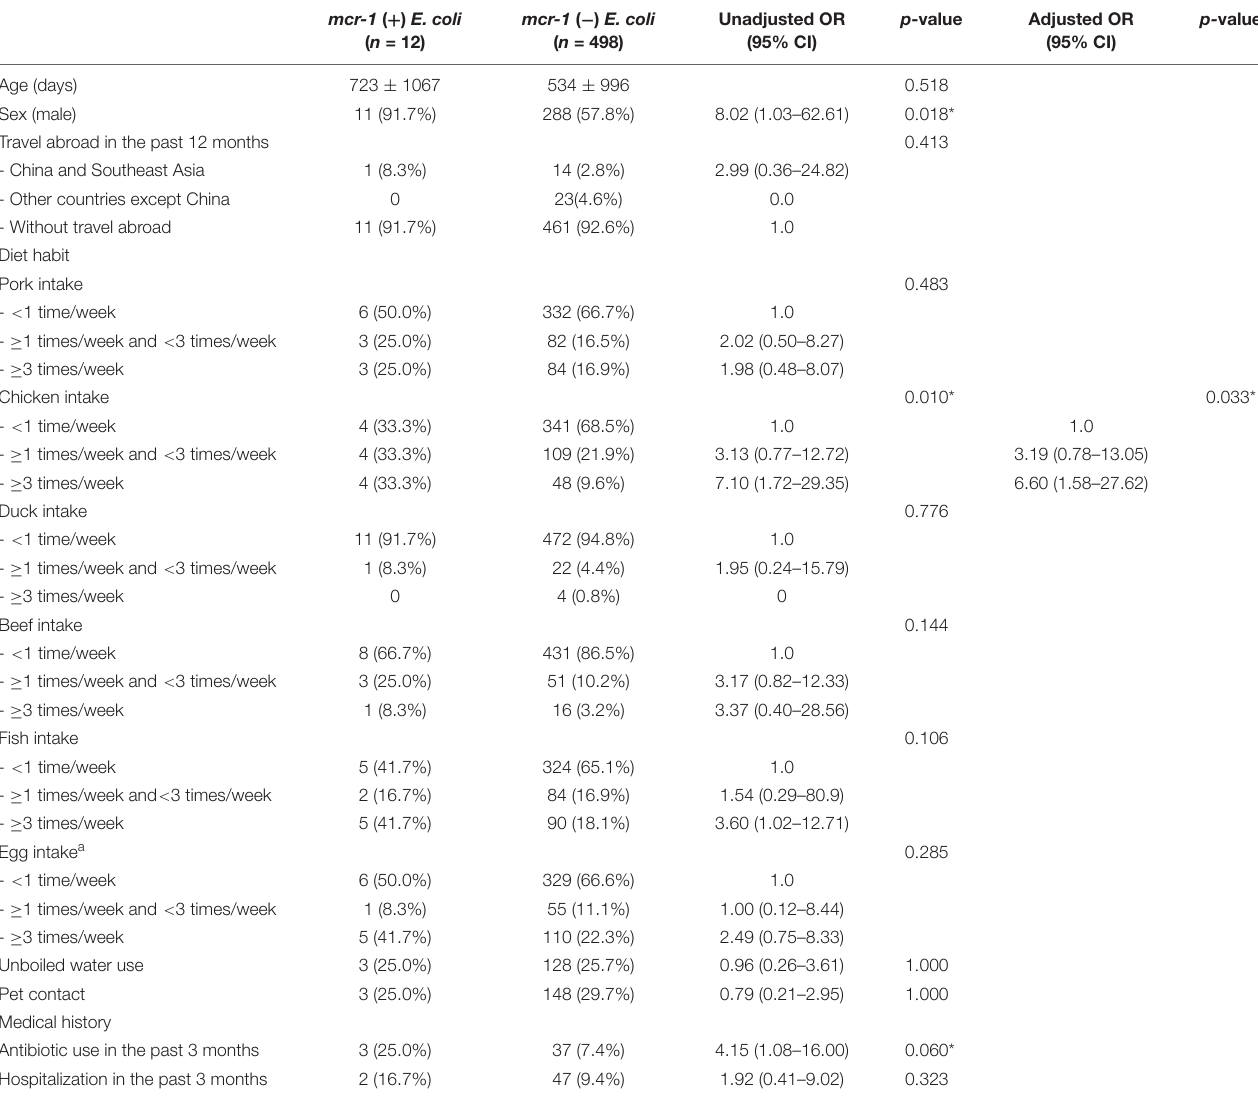
TABLE 1 | Characteristics of 510 participants with and without mcr-1 Escherichia coli in their fecal carriages. mcr-1 ( + ) E. coli ( n =